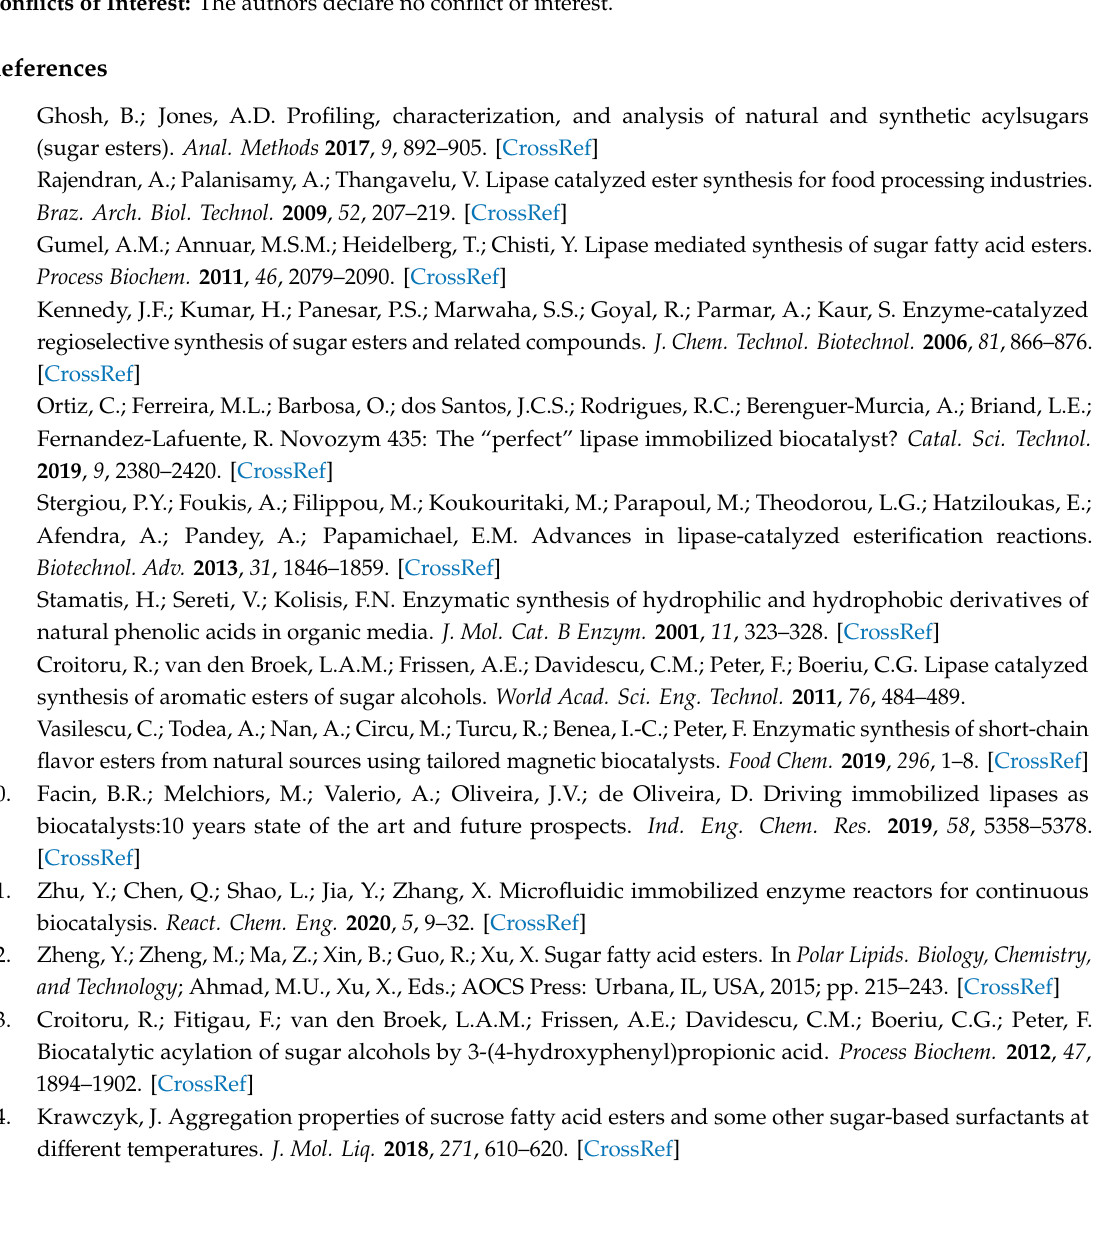
Figure S24. 135 DEPT NMR spectrum of 2,1 (cid:48) :4,6-di- O -isopropylidene sucrose. Figure S25. 13C-NMR spectrum of 2,3:5,6:3 (cid:48) ,4 (cid:48) -tri- O -isopropylidene dimethyl lactose. Figure S26. 1 H-NMR spectrum of 2,3:5,6:3 (cid:48) ,4 (cid:48) -tri- O - isopropylidene dimethyl lactose. Figure S27. 135DEPT NMR spectrum of 2,3:5,6:3 (cid:48) ,4 (cid:48) -tri- O -isopropylidene dimethyl lactose. Figure S28. MALDI-TOF MS spectrum of the reaction mixture after esterification of 2,3:5,6:3 (cid:48) , 4 (cid:48) -tri- O -isopropylidene dimethyl lactose with HPPA, in tert-butanol at 60 ◦ C in the presence of Novozyme 435. Scheme S1. Reaction scheme of 2,3: 5,6: 4 (cid:48) , 6 (cid:48) -tri- O -isopropylidene dimethyl lactose and 2,3: 5,6: 3 (cid:48) , 4 (cid:48) -tri- O -isopropylidene dimethyl lactose synthesis by acetalization of lactose with 2,2-dimethoxypropane in the presence of p -toluenesulfonic acid, at reflux, 24 h. Table S1. Transesterification reaction conversions of α - d -glucose, sucrose, lactose, inulin with methyl 3-(4-hydroxyphenyl) propionate (HPPME) catalyzed by native lipases after 72 h of